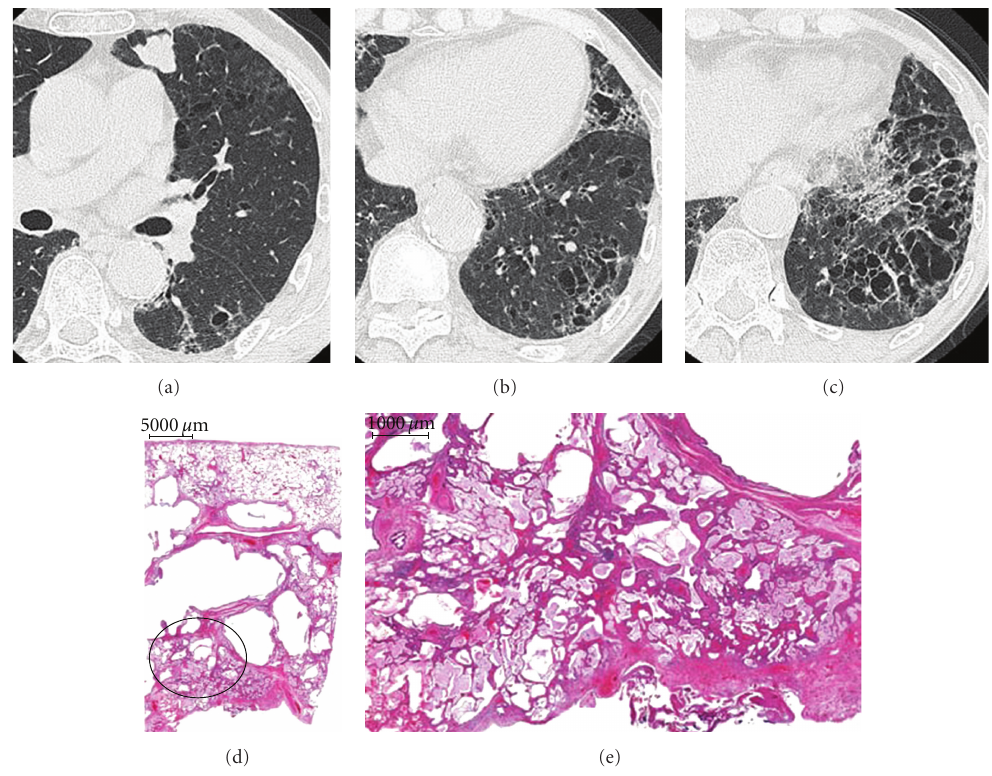
Figure 4: Emphysema with fibrosis, thick-walled large cyst. (a) HRCT of upper lungs shows severe centrilobular emphysema. A relatively thick-walled cyst in the superior basal segment of the left lower lobe. Lung cancer is noted in the lingual division of the left upper lobe. (b) HRCT of left lower lung shows large thick-walled cysts surrounded by ground glass opacity in the regions apart form pleural surface. (c) HRCT of left lower lobe shows multiple bizarre-shaped cysts aggregated in the central portion of the left lower lobe. (d) Pathologic specimens of the resected left upper lobe shows centrilobular cystic lesion involving the membranous and respiratory bronchioles with fibrosis. Note peripheral lung parenchyma spared. (e) Mucus filling in the alveoli with slight septal thickening adjacent to the cyst (circle of Figure 5(e)). Mucus filling and septal thickening correspond to ground glass opacity surrounding large cysts.